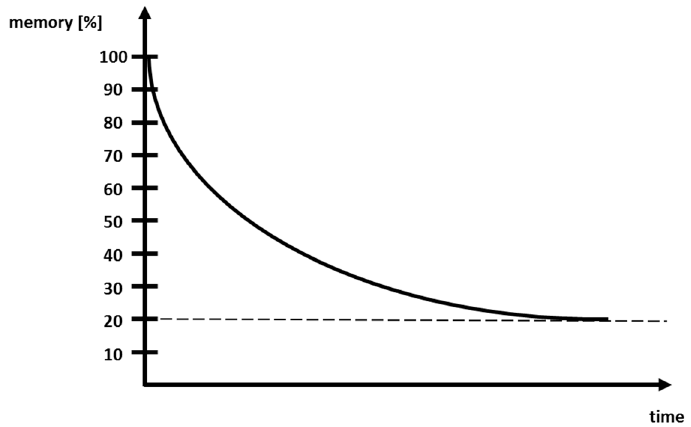
Figure 2. Human forgetting curve. This shows the human memory capability and that the human awareness decreases over time following an exponential function.